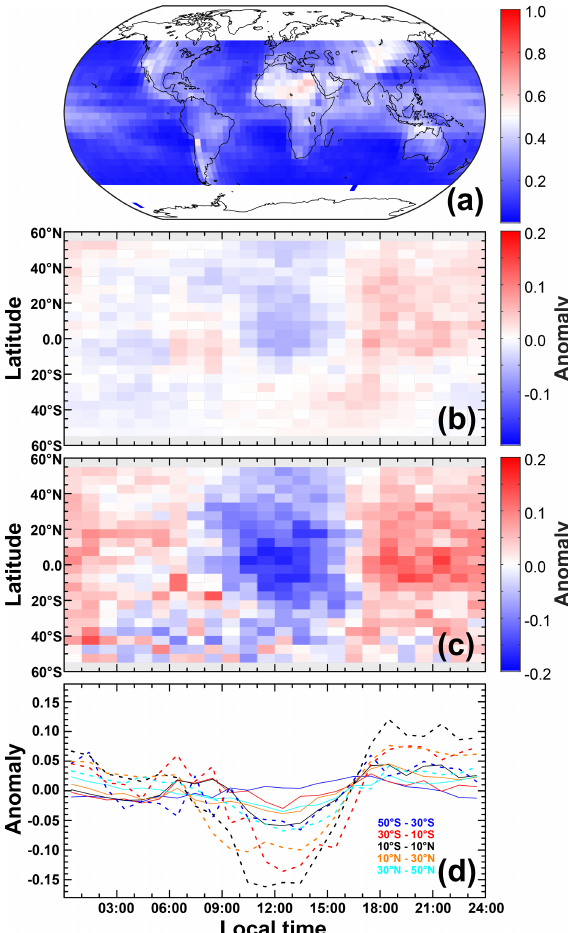
Figure 7. Occurrence rate of isolated ice clouds in CATS obser- vations between March 2015 and October 2017 as (a) global dis- tribution, (b) and (c) anomaly in the diurnal variation of the zonal distribution over all surfaces and land only, and (d) anomaly in the diurnal variation of the zonal average in five latitude bands: 50– 30 ◦ S (blue), 30–10 ◦ S (red), 10 ◦ S–10 ◦ N (black), 10–30 ◦ N (or- ange), and 30–50 ◦ N (light blue) over all surfaces (solid) and land only (dashed). The anomaly is calculated as the difference between hourly values and the daily mean value.